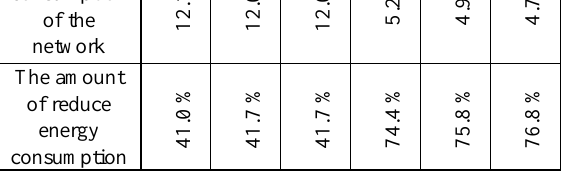
Table 2: Results of the performance of the K-means and ANT Colony algorithms in reducing the energy